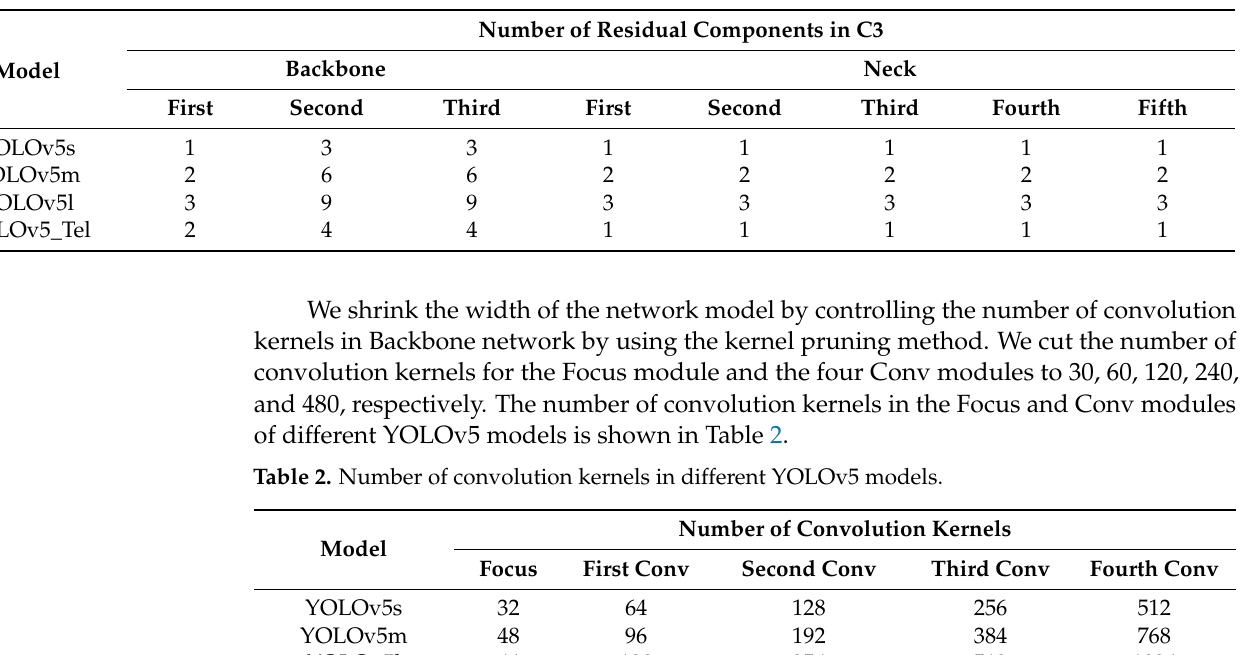
Table 1. Number of residual components in C3 modules in different YOLOv5 models.